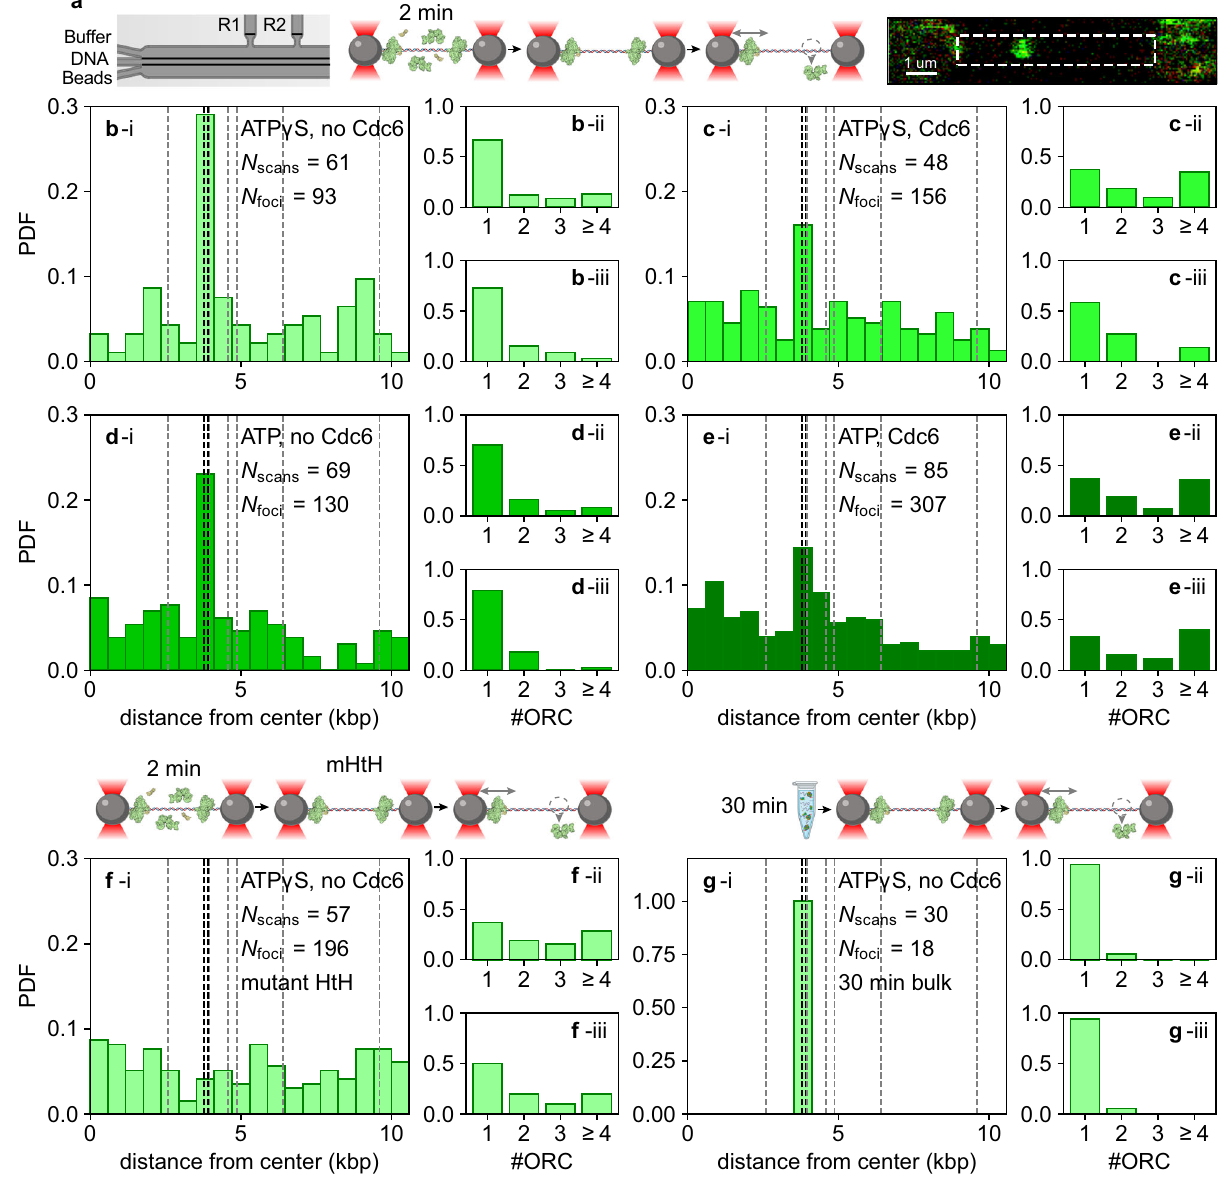
Fig. 1 The spatial distribution of ORC is dominated by the origin. a From left to right: scheme of the fl ow cell, experimental work fl ow, and a representative image of labeled ORC bound to a single DNA molecule. The dashed square highlights the region used for data analysis. A DNA molecule is tethered to beads that are trapped in a dual-beam optical trap, allowing the DNA to be held under tension. When labeled ORC is introduced and binds to the DNA, it is excited by an integrated confocal laser scanning system (for further details, see Methods). b – e (i) Histograms of the spatial distribution of DNA-bound JF549-ORC following a 2 min-long incubation. (ii) Distribution of the stoichiometry of ORC foci everywhere on the DNA, and (iii) within 0.2 µ m of the HtH origin (iii). Speci fi c conditions are: b incubation of ORC in ATP γ S; c ORC and Cdc6 in ATP γ S; d ORC in ATP; e ORC and Cdc6 in ATP. f As in b , except that DNA contains the mHtH origin as described in Supplementary Fig. 7. g As in b , except that JF549-ORC is incubated with the 21.2 kbp DNA in bulk for 30 min before being introduced into the fl ow cell and imaged as in b – e . Bold dashed lines in the seventh bin from the left indicate the head-to-head (HtH) high-af fi nity ORC-binding sites. Faint dashed lines indicate near-cognate binding sites elsewhere on the